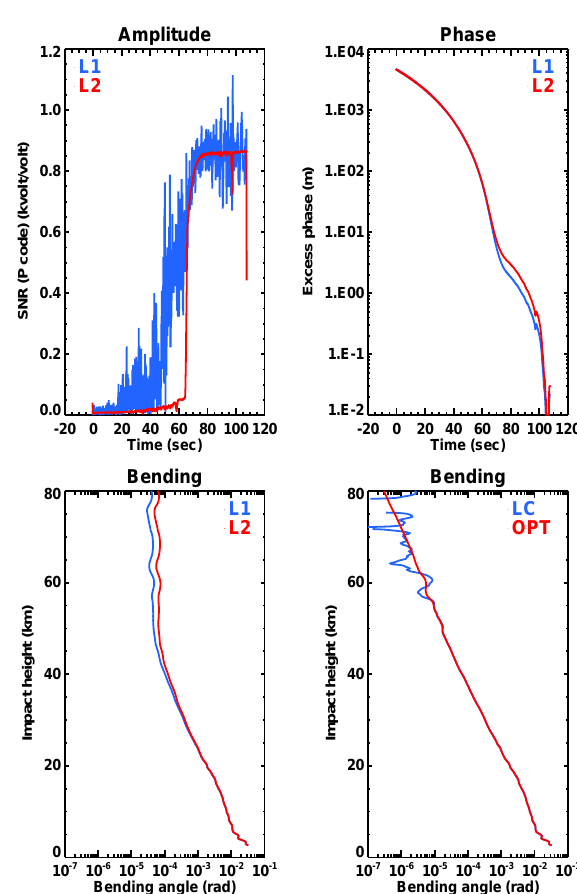
Figure 3. The results of passing the “atmPhs” COSMIC phase/amplitude data of Fig. 2 through ropp_pp_occ_tool . Top left: L1 and L2 signal-to-noise ratios (preprocessed); top right: L1 and L2 excess phases (preprocessed); bottom left: resulting L1 and L2 bending angles; bottom right: “linearly combined” (LC) and “statistically optimised” (OPT) ionospherically corrected bending